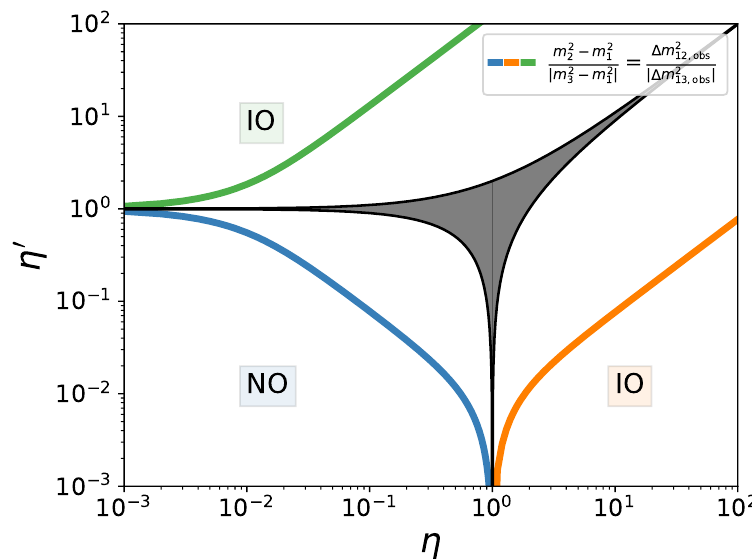
Figure 1 . Regions in the (cid:17) (cid:0) (cid:17) 0 plane, with (cid:17) > (cid:17) 0 , where normal or inverted ordering is realized, i.e. where the conditions m 1 < m 2 < m 3 (NO) or m 3 < m 1 < m 2 (IO) hold. There is one region for NO and two disconnected regions for IO. The central dark-shaded region is inconsistent with oscillation data as it corresponds to m 1 < m 3 < m 2 . The solid curves are the loci of points that satisfy the constraint from neutrino oscillation measurements on the ratio (cid:1) m 2 parameter space is symmetric for re(cid:13)ection around the bisector, i.e. (cid:17) $ (cid:17) 0 , so that one can focus only on the (cid:17) > (cid:17) 0 region (see text for